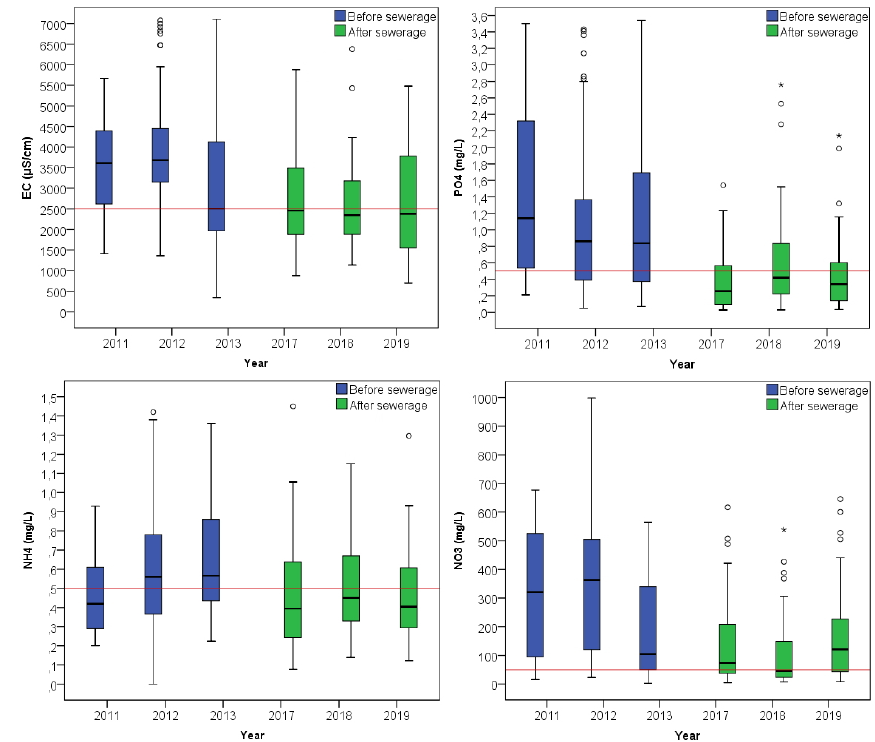
Figure 4. Box plots of EC, PO 43 − , NH 4+ and NO 3 − before and after the establishment of the sewerage network. The bottom and top of each box represent the lower and upper quartiles, and the line inside each box represents the median. The red line indicates the contamination limit value.